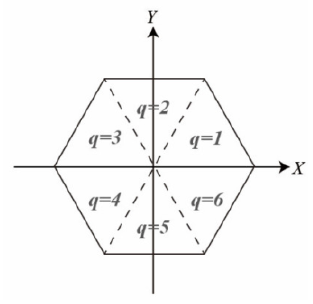
Figure 4. Sextant number ( q ) for the hexagonal pagoda